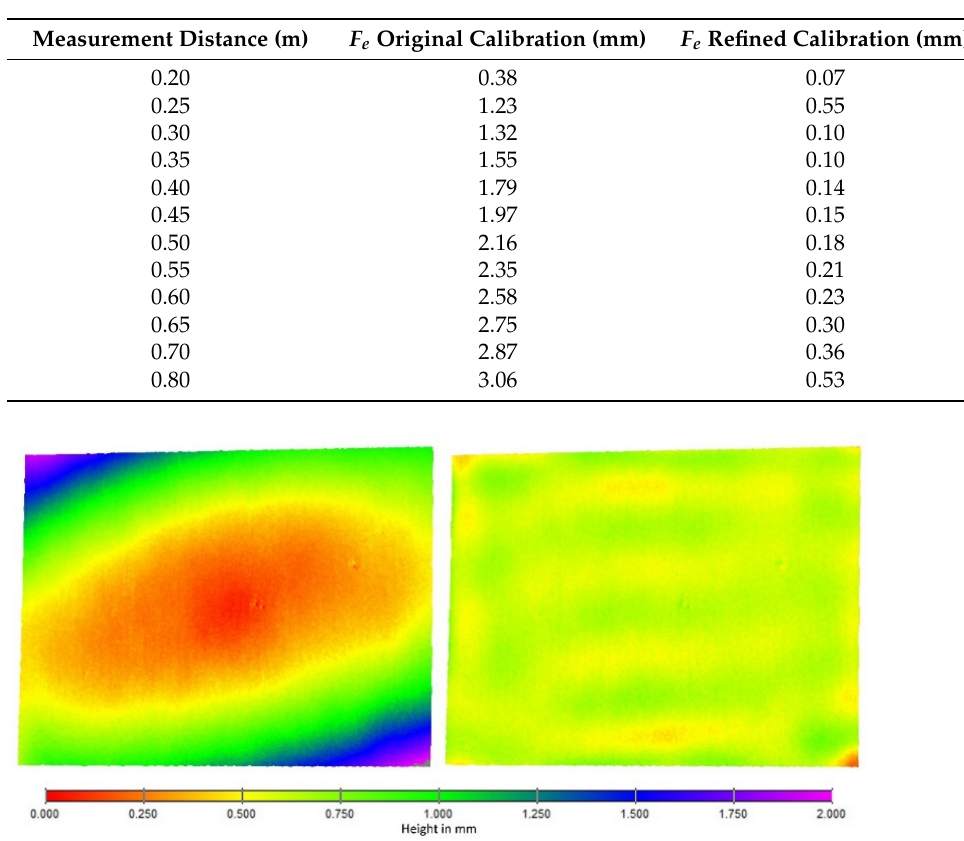
Table 1. Flatness error F e depending on measurement distance before and after calibration refinement. The measured reference area was about 300 mm × 200 mm.